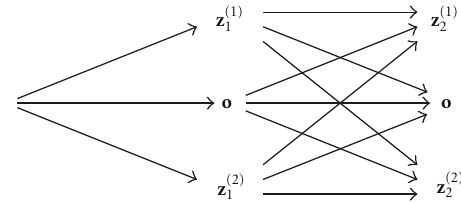
Figure 4: Hypothesis generation: In every time scan, the number of hypotheses increases by the factor m k +1 (number of measurements plus event of missed detection). A missed detection is illustrated by a